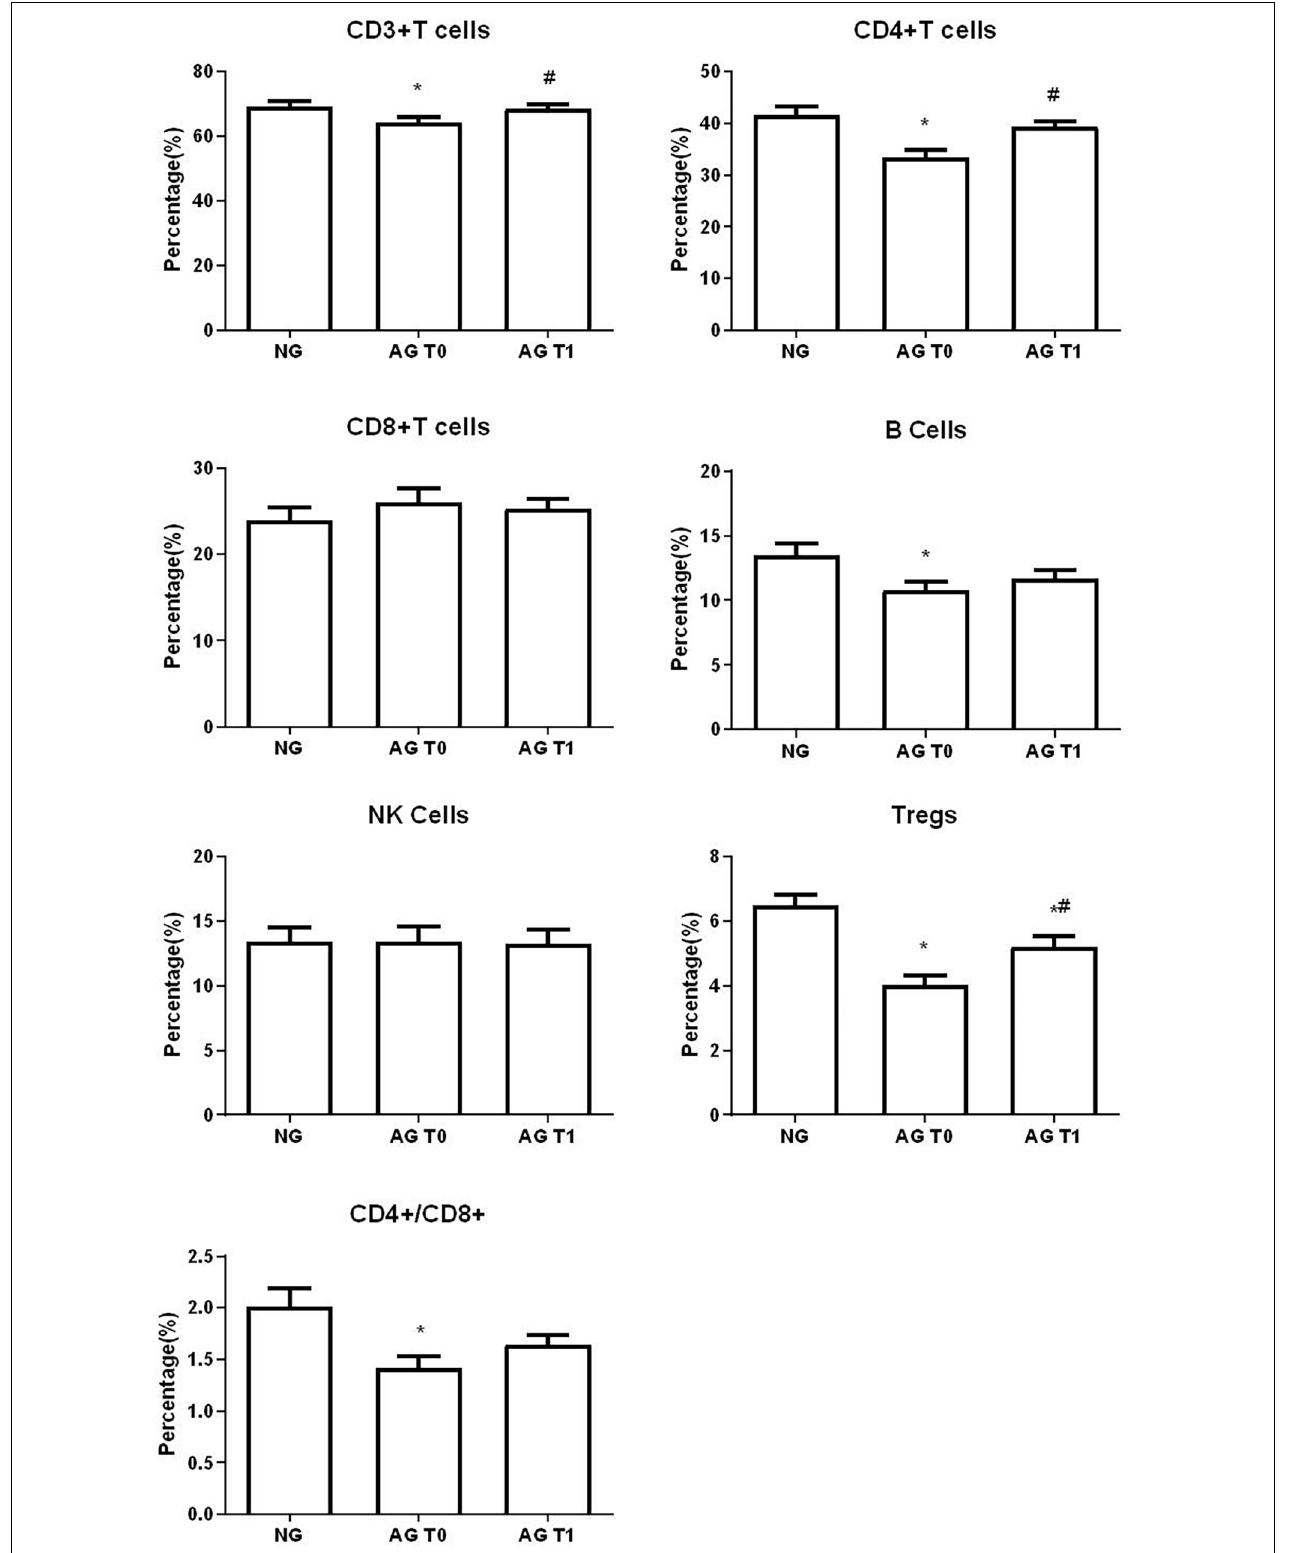
FIGURE 4 | Percentage of lymphocyte subsets in peripheral blood. NG, normal group; AG, acupuncture group; T0, before treatment; T1, after treatment. *Compare with the healthy elderly people, P < 0.05. # Compare with the conditions before treatment, P < 0.05.